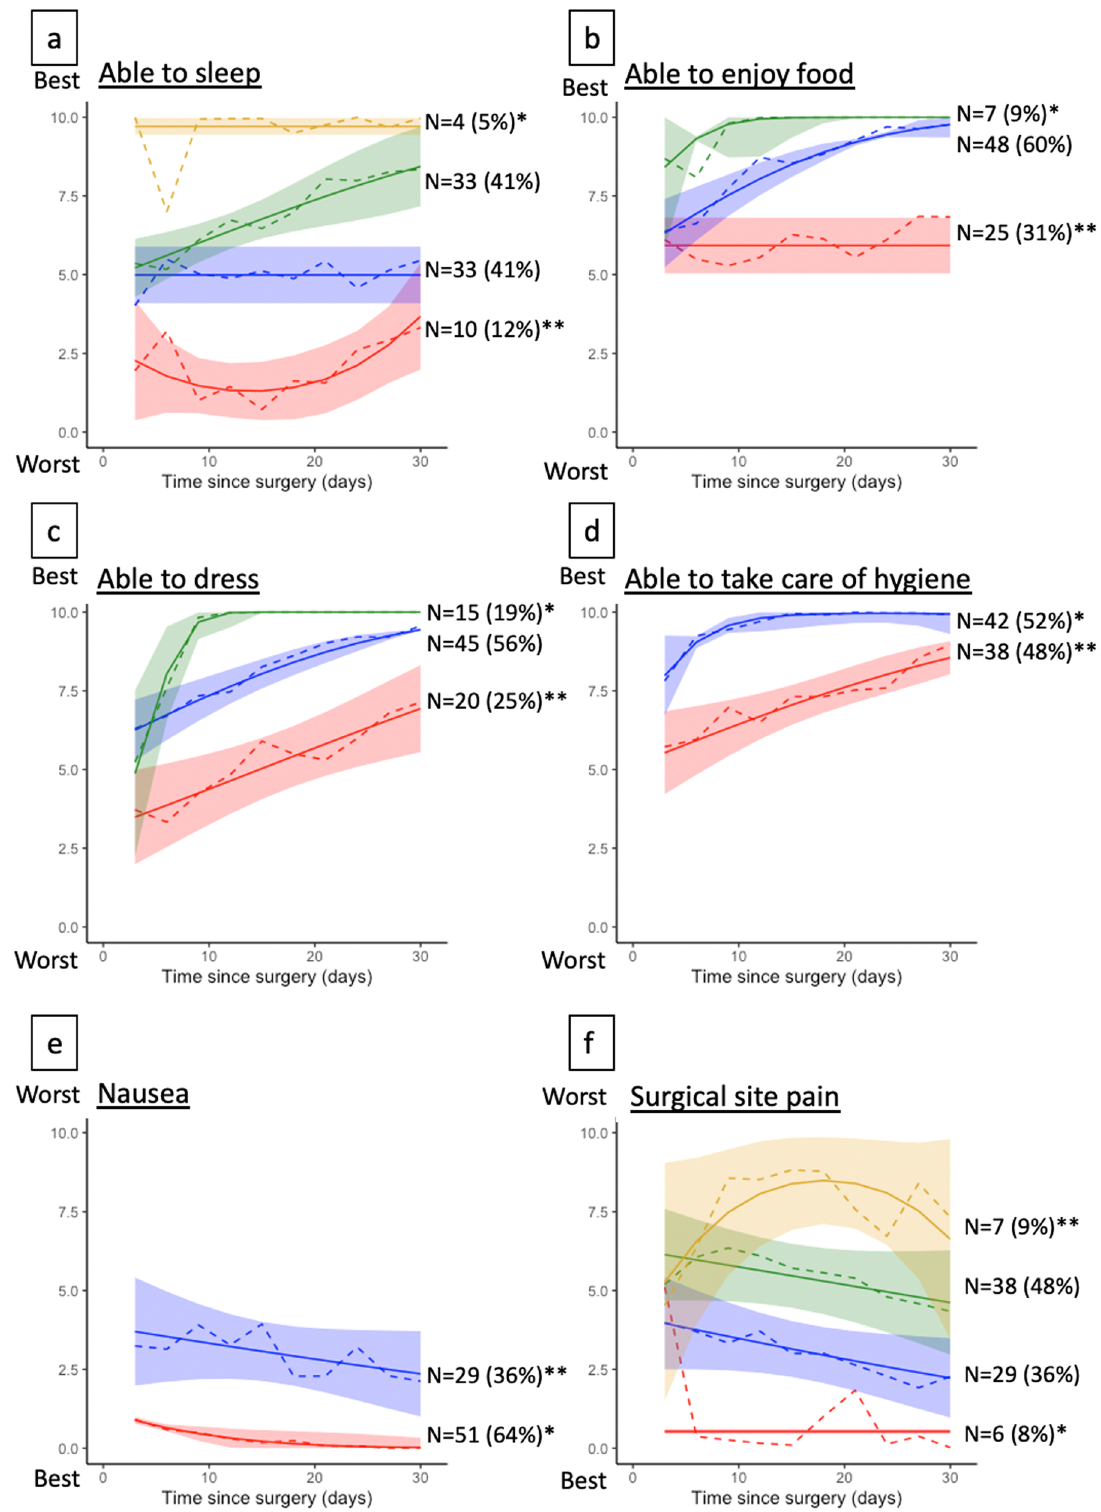
Fig. 3 Trajectories of recovery by sleep, food, activities of daily living, and nociception. The fi gure shows trajectories of recovery in sleep, ability to enjoy food, activities of daily living, nausea, and pain. All questionnaire responses in these domains yielded three dominant trajectory groups, except for nausea and hygiene, which yielded 2 trajectory groups, and pain and sleep, which yielded four trajectory groups. Trajectories with single asterisk (*) denotes the best recovery trajectory and those with double asterisks (**) denote the worst trajectory. Colors are used for visualization purposes and do not correspond to better or worse trajectories. Patients ’ ability to sleep ( a ), ability to enjoy food ( b ), ability to dress ( c ), ability to take care of hygiene ( d ), feeling of nausea ( e ), and surgical site pain ( f ) are